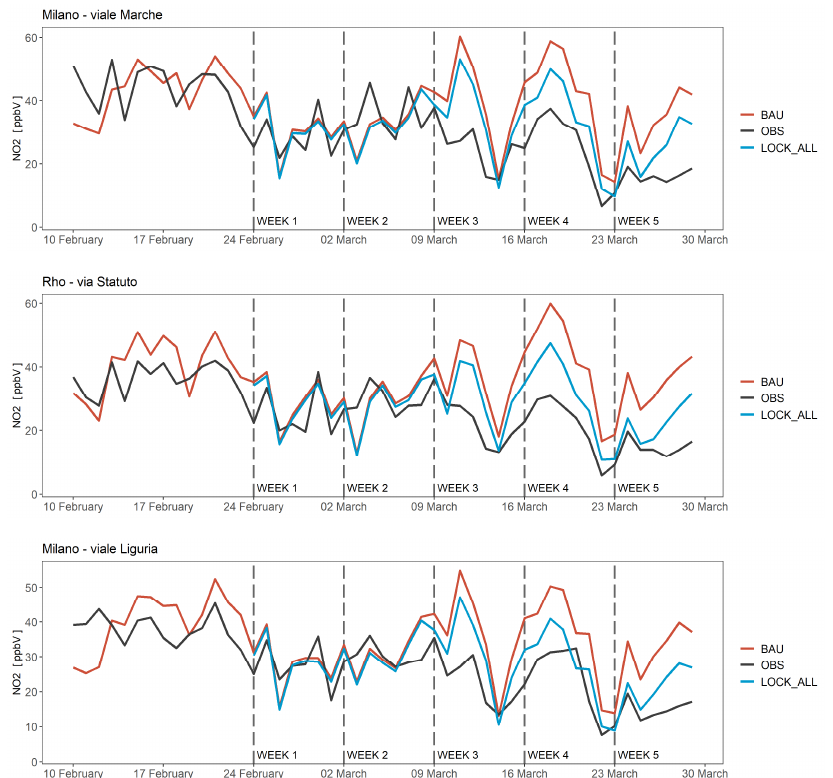
Figure 9. NO 2 time series simulated for the BAU (red) and LOCK_ALL (light blue) scenarios, compared to the observations (black) in the city of Milan selected monitoring sites.